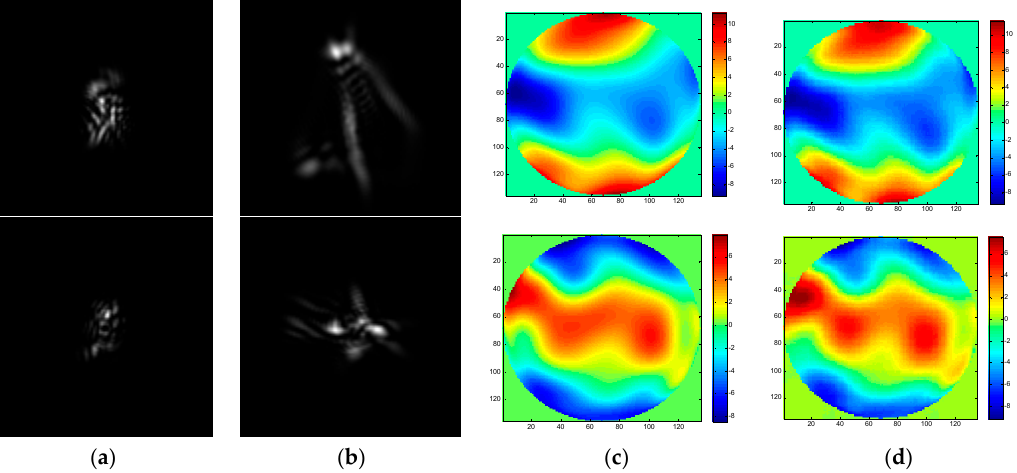
Figure 5. Predicting effect of ( a ) the initial in focus PSF images; ( b ) the initial defocus PSF images; ( c ) the initial wavefront maps; ( d ) the wavefront maps by the De-VGG predicted for D/r 0 = 10.